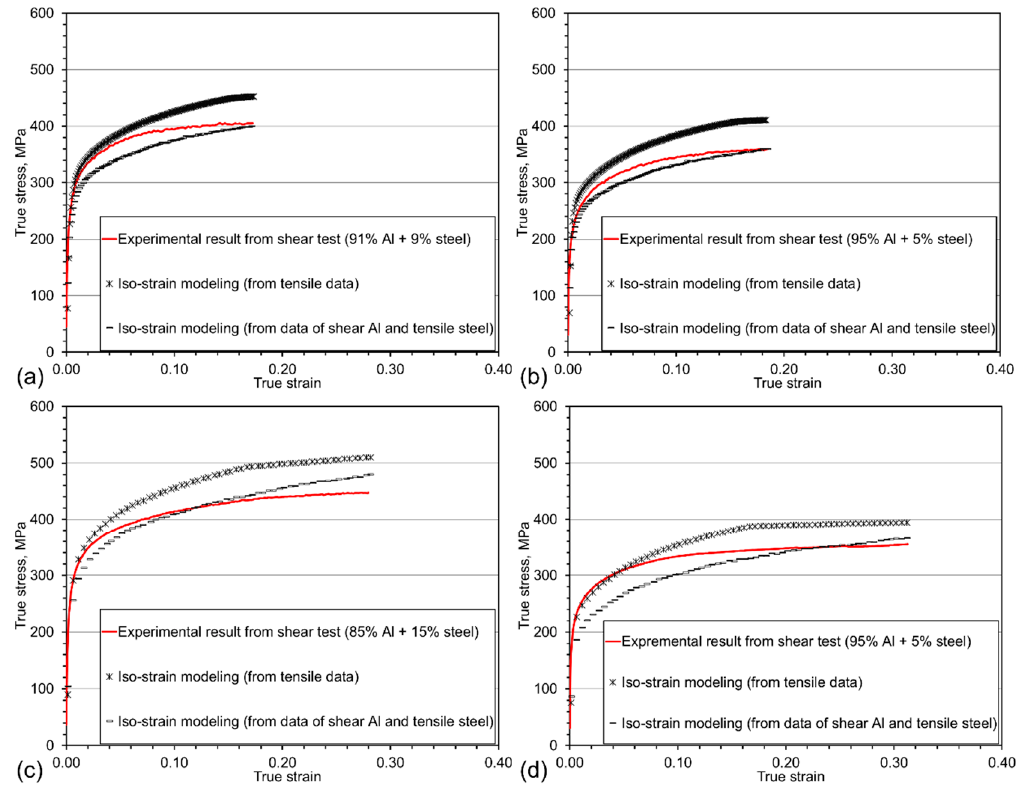
Figure 20. Linear modeling compared with the experimental results at different RPs. ( a , b ) at RP of 1.0 mm/rev with different volume fractions and ( c , d ) at RP of 0.5 mm/rev with different volume fractions.